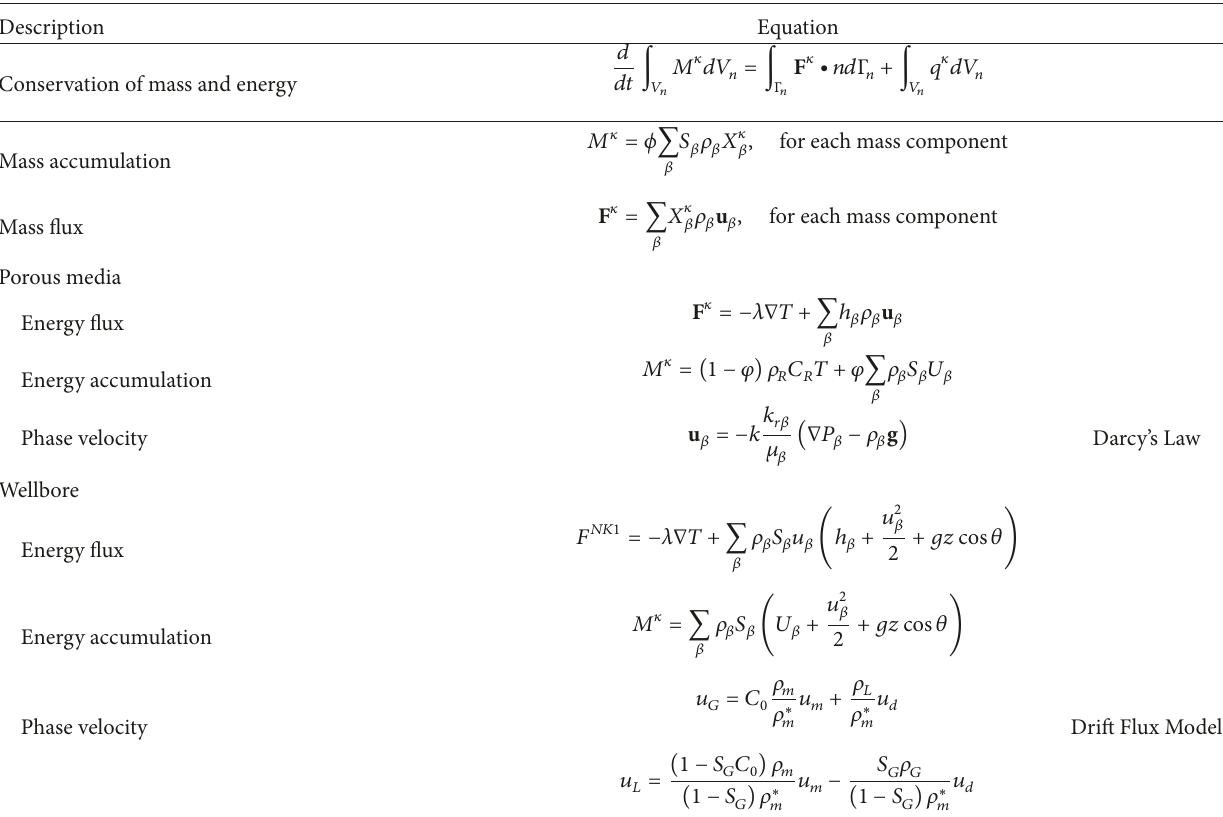
Table 4: Equations applied for different regions in T2Well.